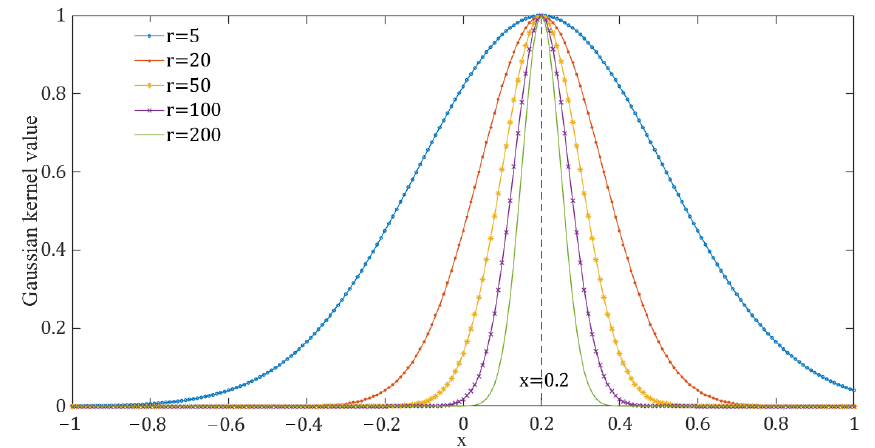
Figure 2. Data distribution of Gaussian kernel (test point x = 0.2).